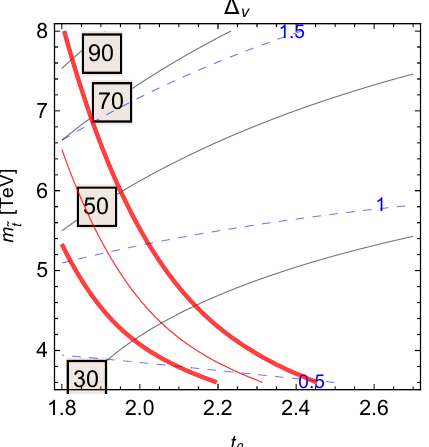
Figure 13 . The total (cid:12)ne-tuning of the electroweak scale v with respect to all the underlying parameters in the D -term model. We also show the values of the vev f in unit of TeV with blue dashed lines. The numerical benchmark values used for this plot are included in table 3. The contours of constant tuning have a di(cid:11)erent behavior compared to the F -term model in (cid:12)gure 9. This di(cid:11)erence can be mainly attributed to the dependence of the symmetric coupling (cid:22) (cid:21) on the (cid:12) angle in the two